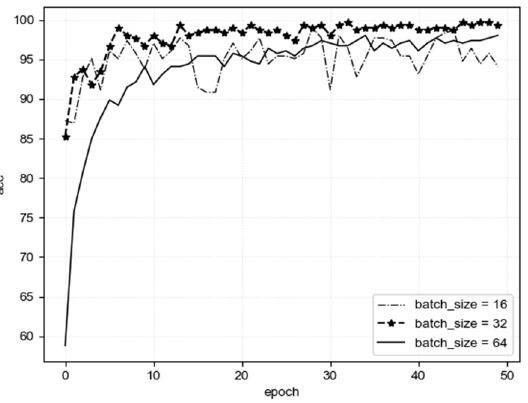
Figure 11. Comparison of experimental results of training networks with different batch_sizes.